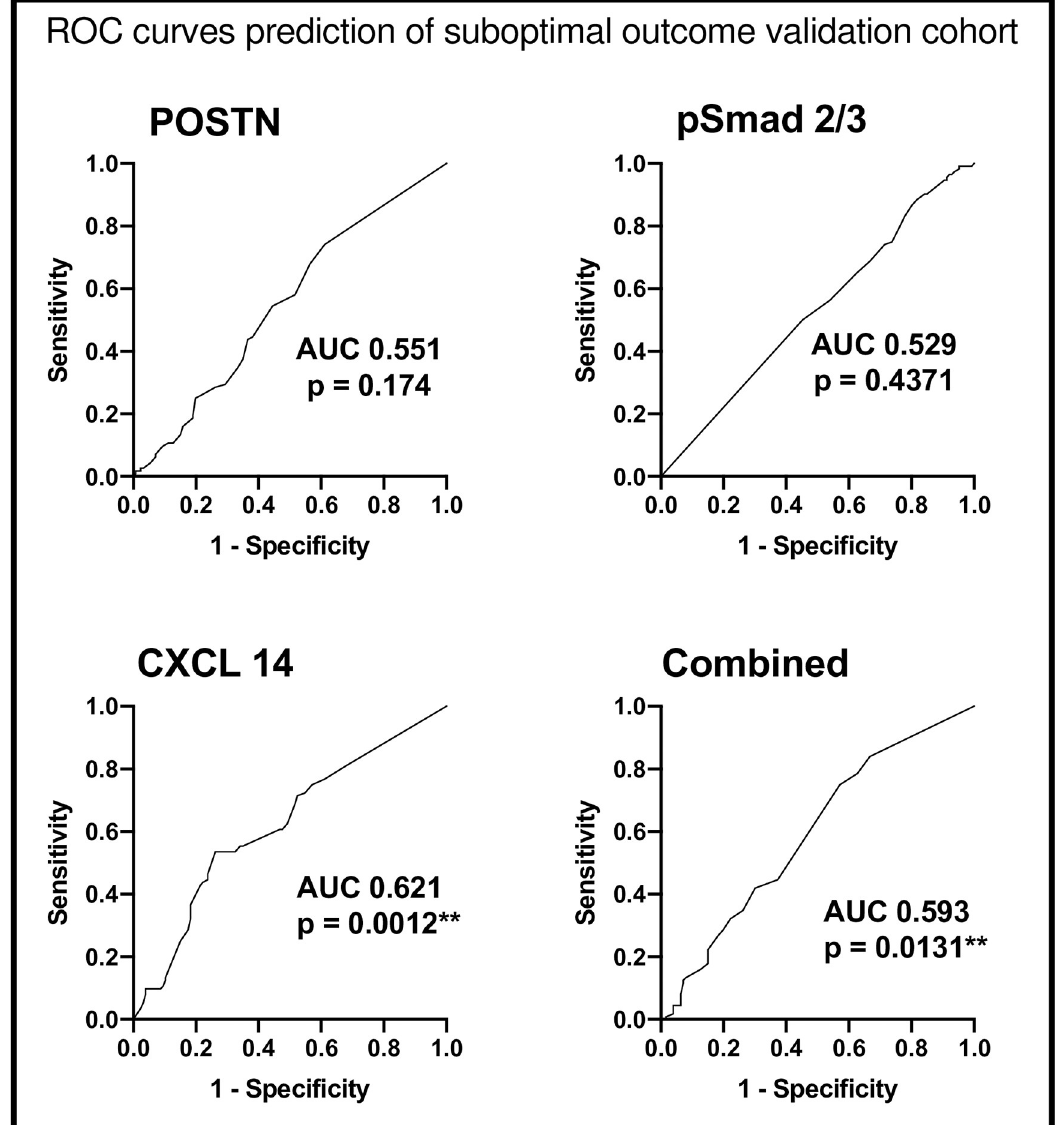
Fig 3. Receiver operating characteristics curves demonstrating poor predictive affinity for suboptimal debulking rates in the validation cohort, n = 238.